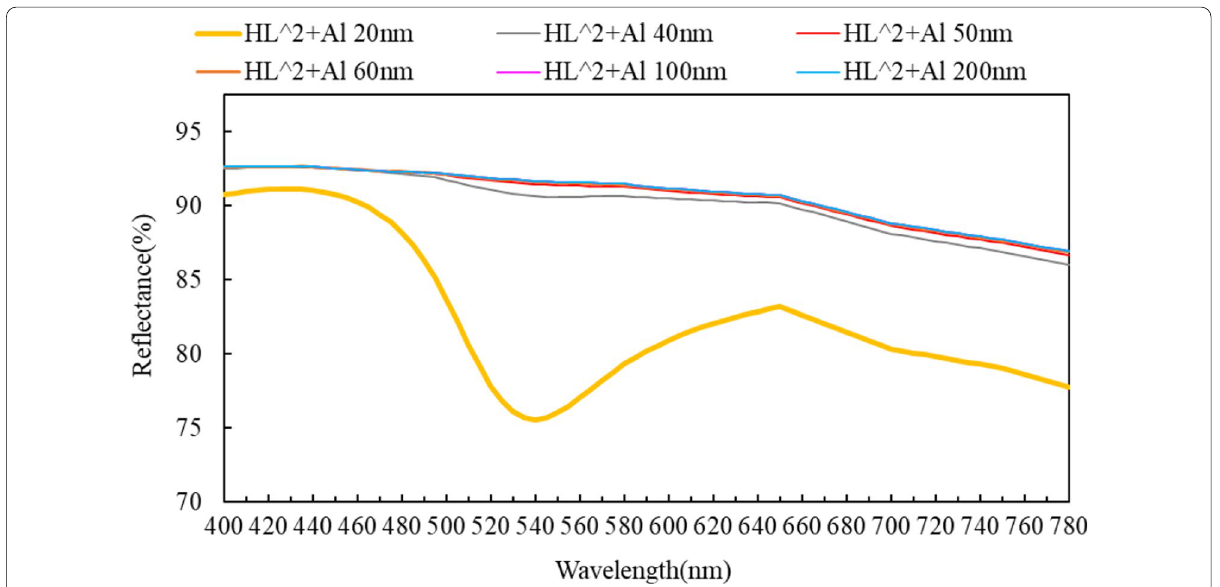
Fig. 15 Reflectance relationship of different wavelengths corresponding to